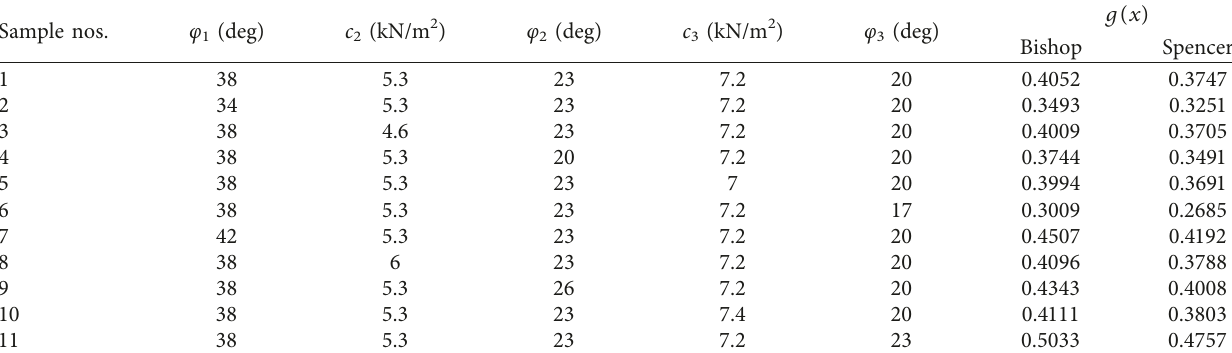
Table 10: The initial learning samples of Example 3.